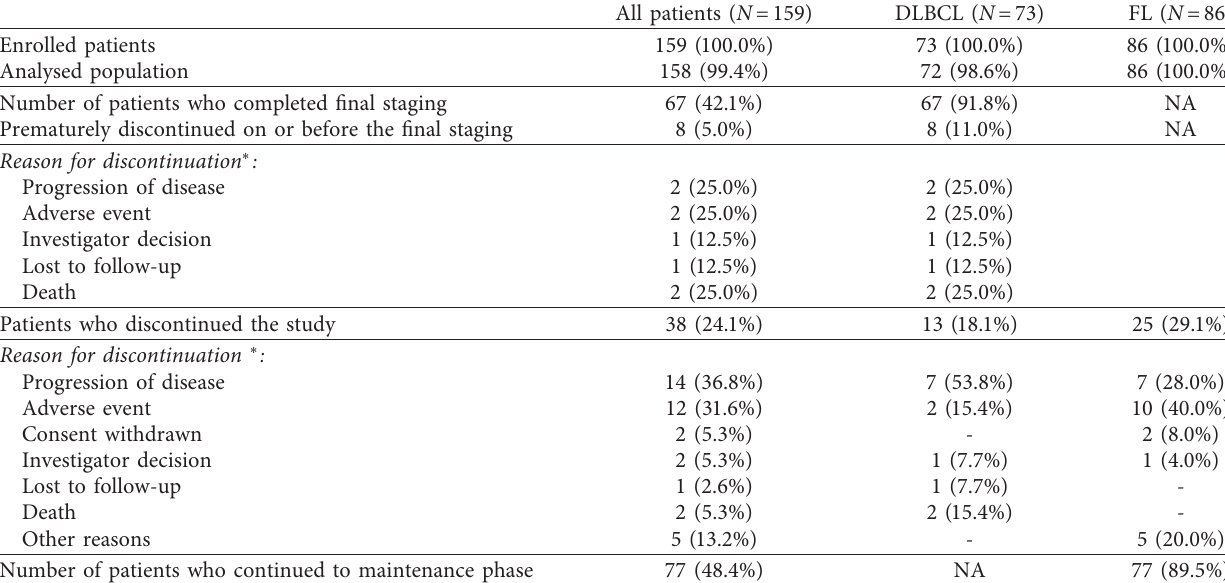
Table 1: Disposition of patients.